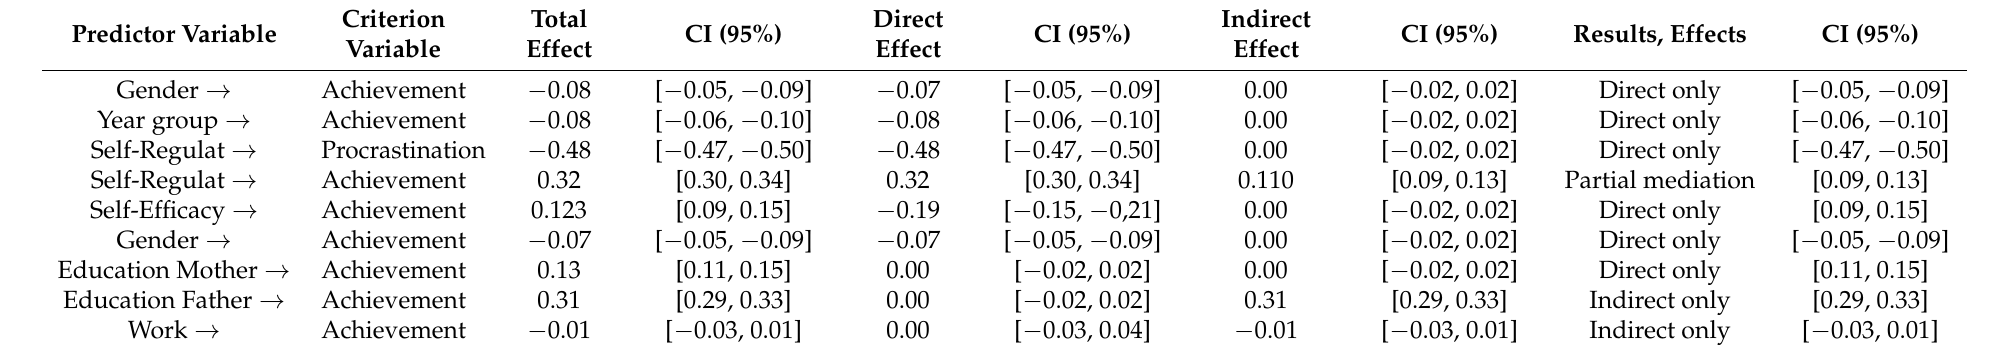
Table 4. Total, indirect, and direct effects of the variables in this study, and 95% bootstrap confidence intervals (CI). Bootstrapping sample size = 430.